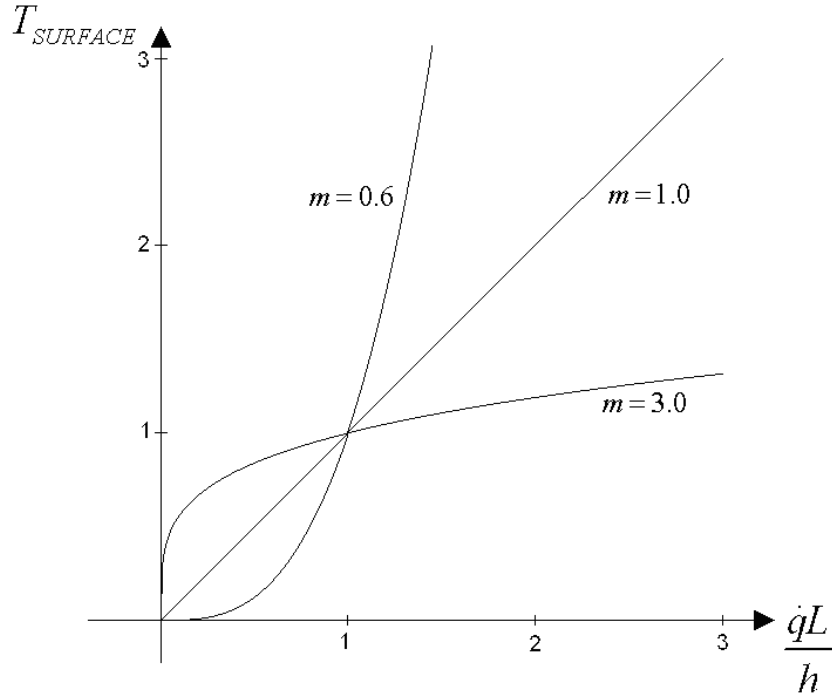
. qL / h for three values of m